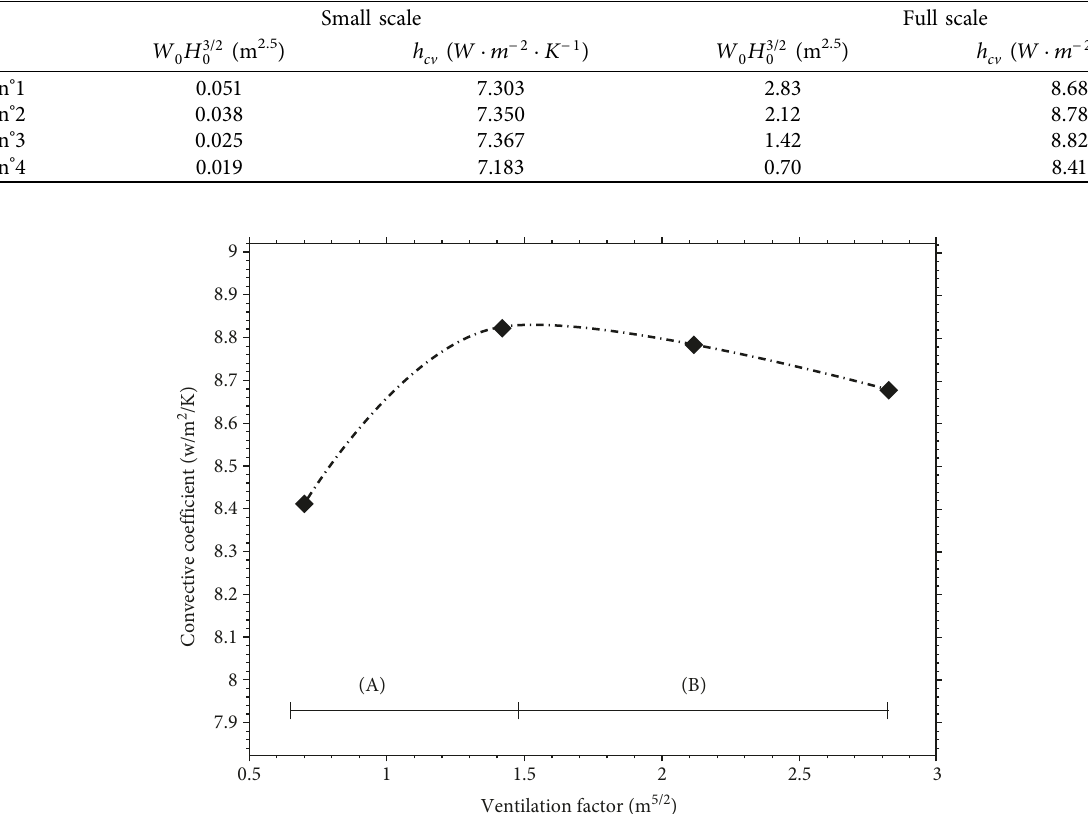
Figure 11: Variation of the convective heat transfer coefficient over the ventilation